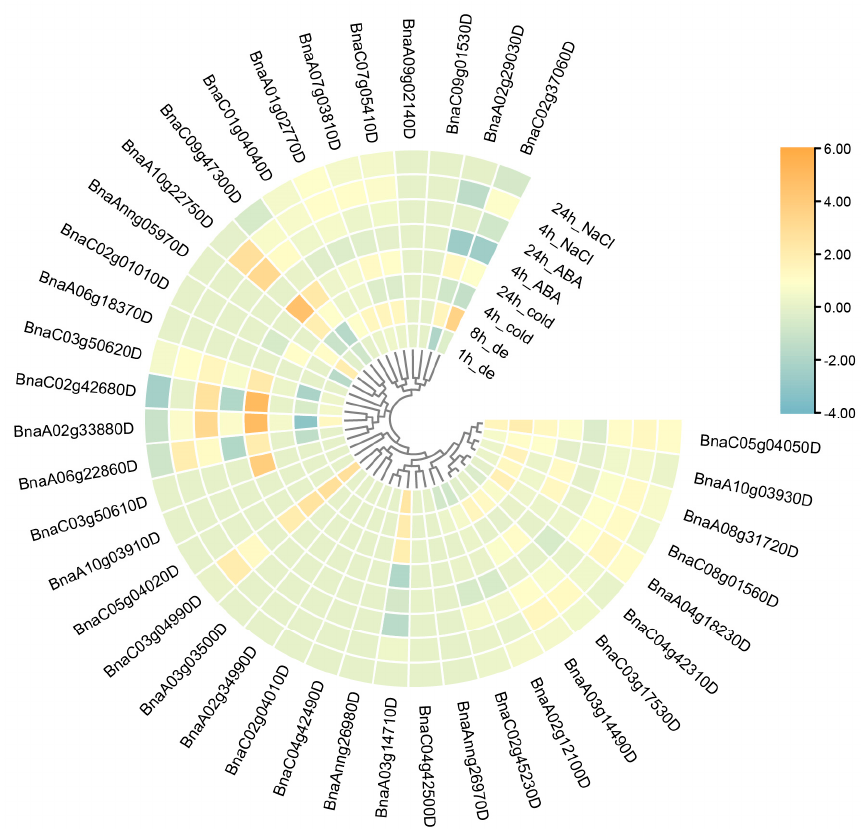
Figure 8. Expression profile of ARI genes under abiotic stress conditions in B. napus . The expression data is processed by comparing the control with each treated sample and calculating the log2 fold change to generate the heatmap. The color bar represents relative expression levels from low (cadetblue) to high (orange).